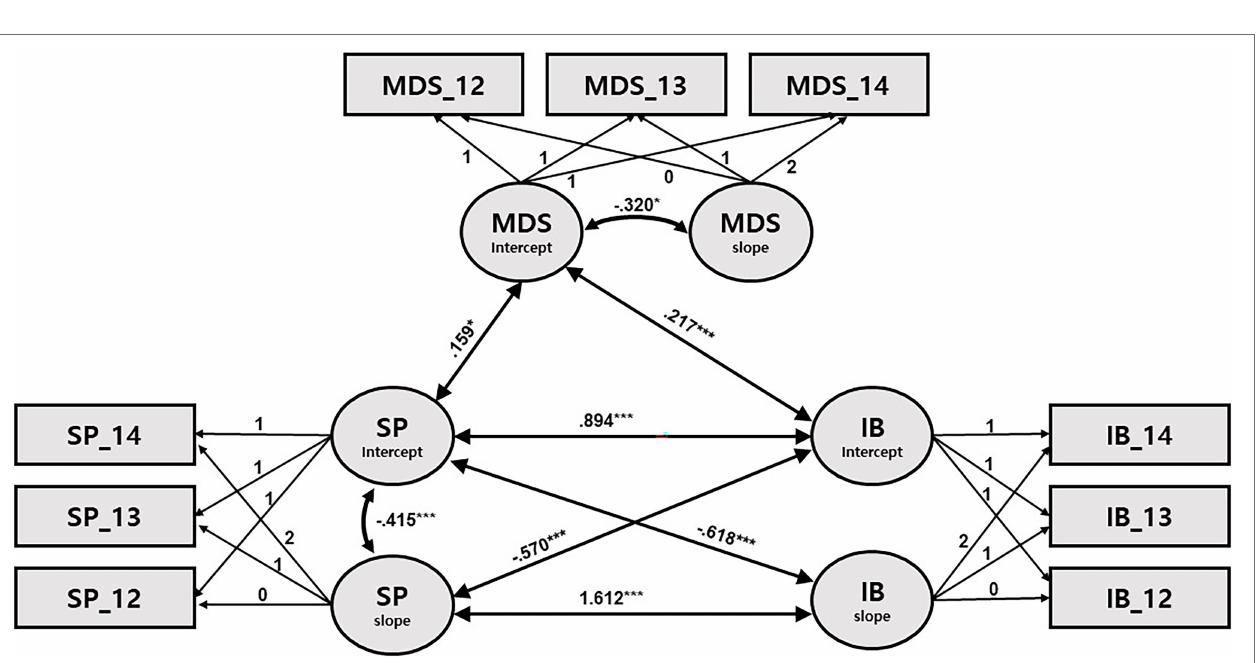
FIGURE 3 | Path diagram for latent growth modeling of sleep problems, externalizing behaviors, and maternal depressive symptoms. SP: sleep problems; EB: externalizing behaviors; and MDS: maternal depressive symptoms. Only significant path coefficients are shown. * p < 0.05, ** p < 0.001, and *** p <